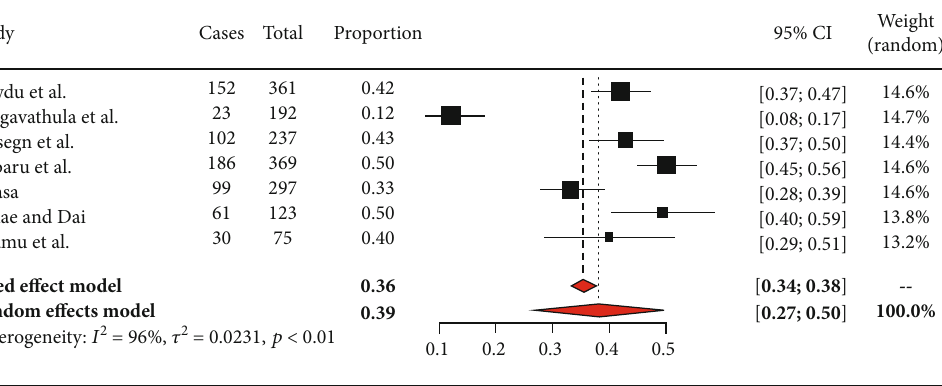
Figure 2: Forest plot for the pooled prevalence of burnout among nurses in Ethiopia from seven observational studies, 2020.